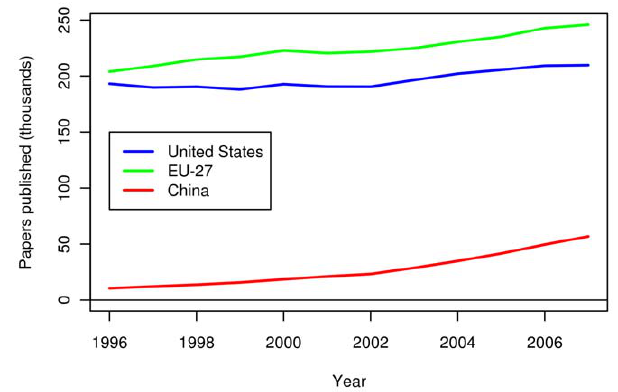
Figure 11. Recent triadic patents granted in the US, the EU-27 and China. Triadic patents are patents which are valid with the United States Patent and Trademark Office, the Japan Patent Office, and the European Patent Office. The blue, green, and red lines show the number of triadic patents granted to American (US), European (within the EU- 27), and Chinese inventors, respectively.